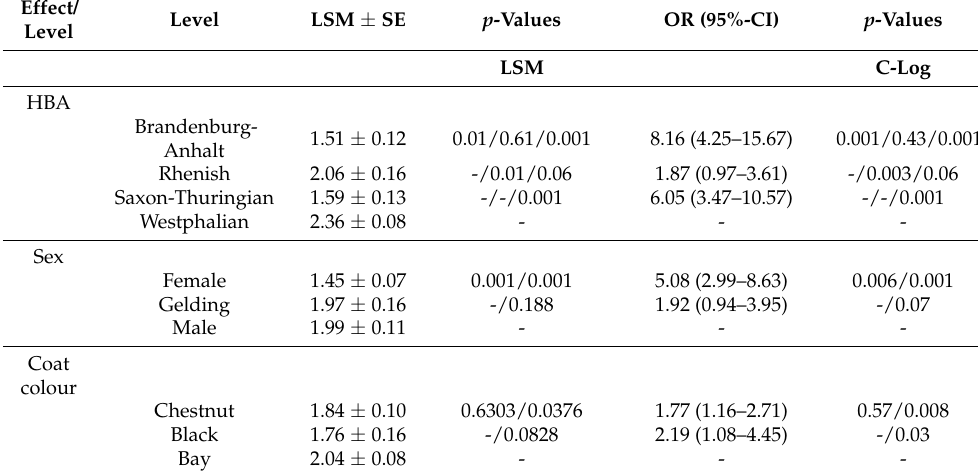
Table 6. Least square mean estimates (LSM) and odds ratios (OR) for the fixed effects of horse breeding association (HBA), sex and coat colour with their standard errors (SE) and 95% confidence intervals (95%-CI) and p -values for CPL-scores (cumulative logit estimates = C-Log or LSM differences) in all Rhenish German draught horses using model 1 with a normal and multinomial distribution